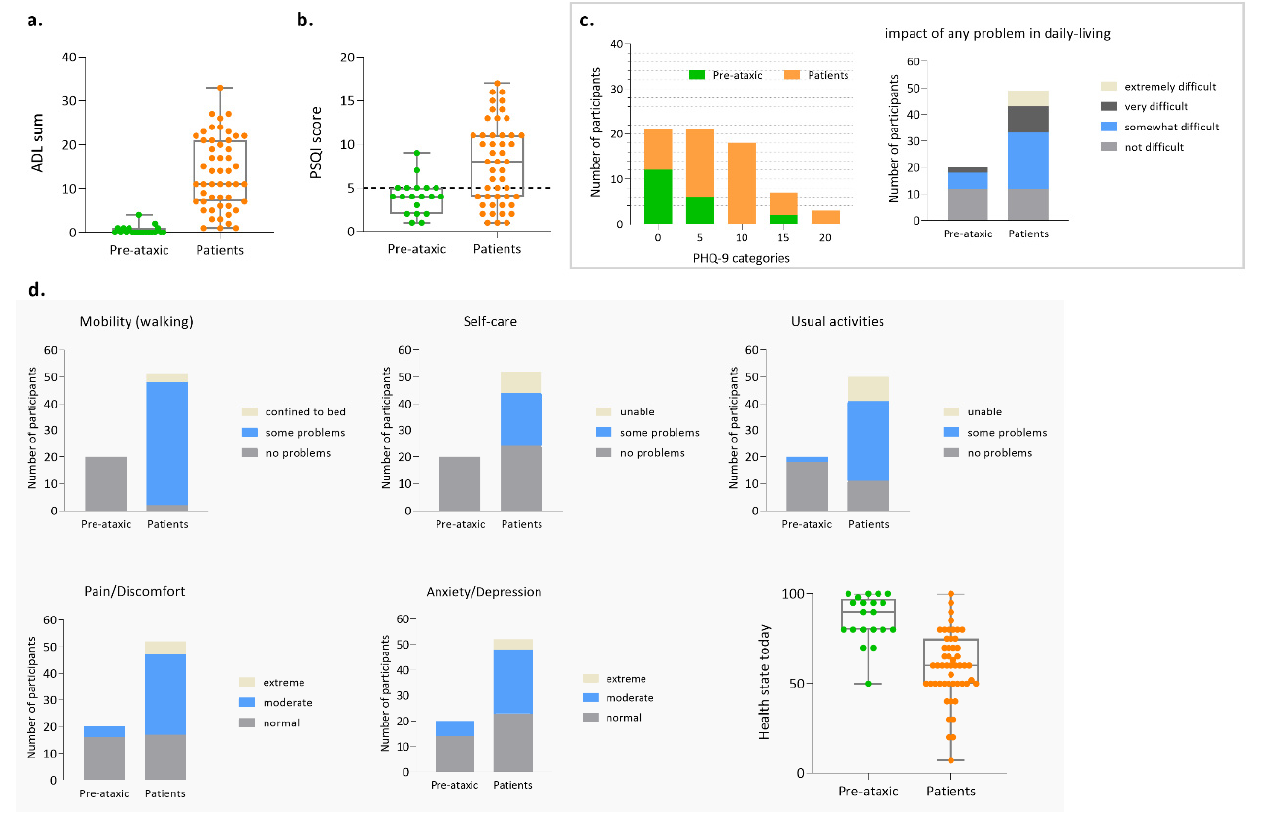
Figure 5. Patient-reported measures for the Azorean MJD cohort. ( a ) Score for the activities of daily living (ADL) questionnaire; ( b ) Score for the Pittsburgh Sleep Quality Index (PSQI); ( c ) Score for the Patient Health Questionnaire (PHQ-9); ( d ) Score for the EQ-5D-3L.